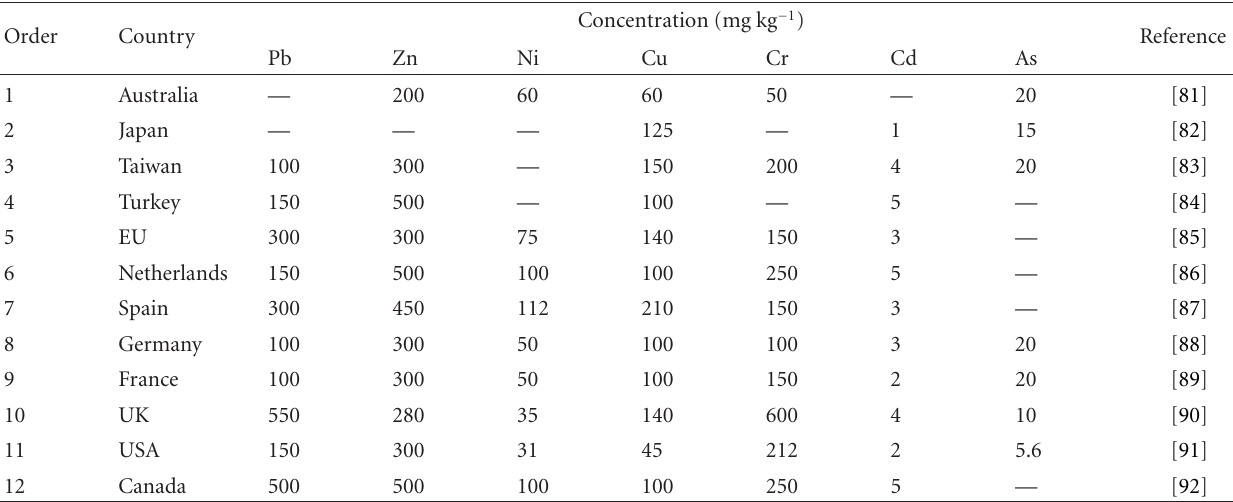
Table 6: Regulatory levels for soil metals established between di ff erent